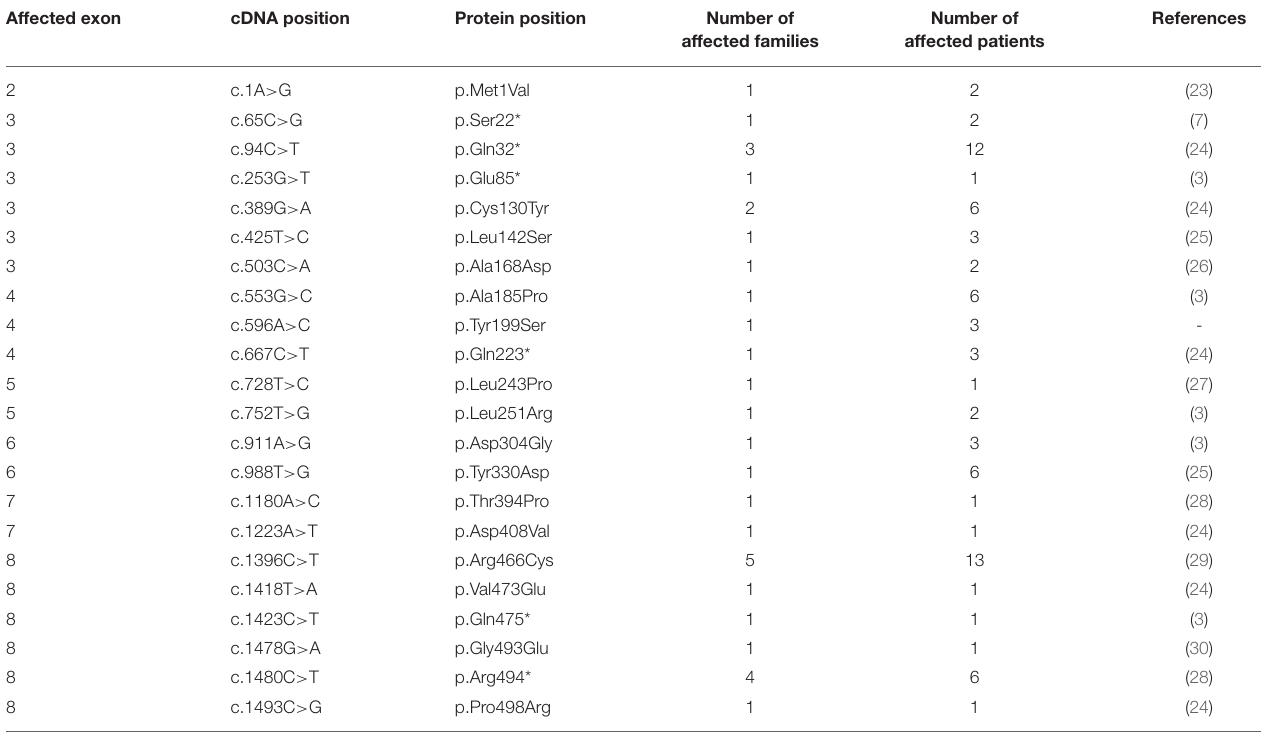
TABLE 2 | Missense and nonsense mutations identified in the SERPING1 gene. Affected exon